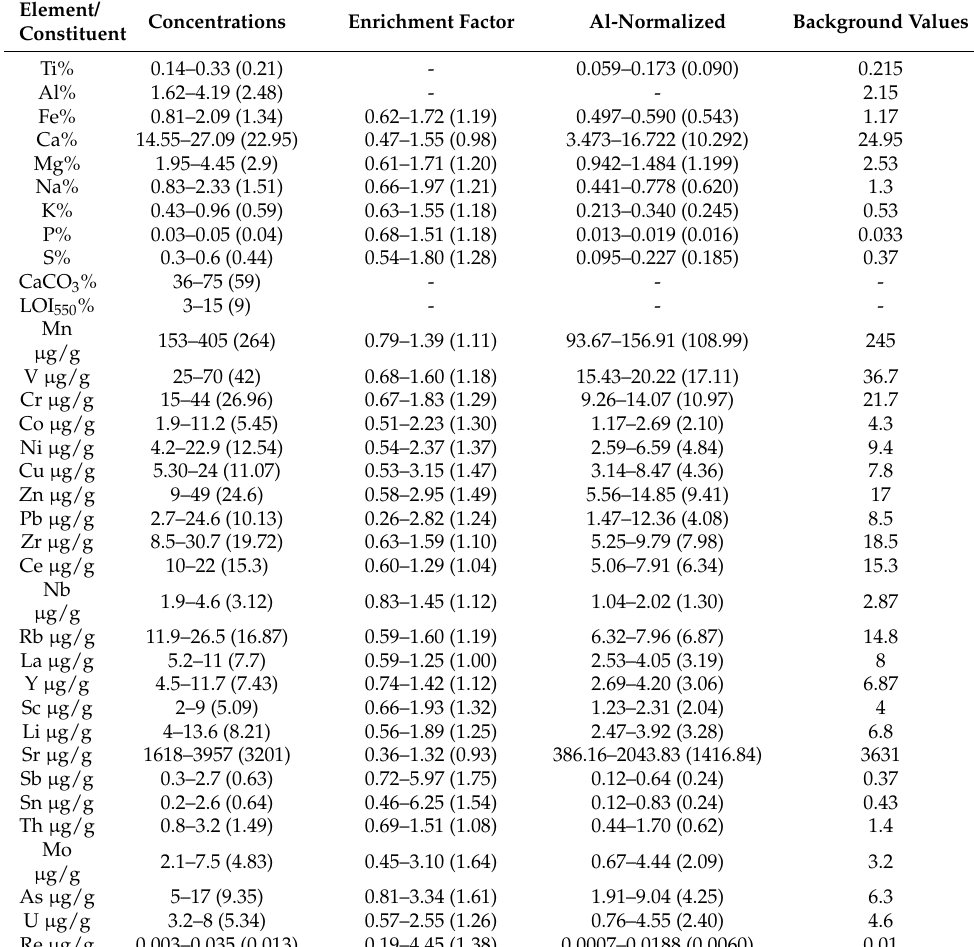
Table 1. Results of chemical analysis of the shallow subsurface coastal sediments of the creek that was connecting the two Al-Shuaiba Lagoons. Ranges and average (in brackets) of concentrations, enrichment factor ( EF ), Al-normalized elements, and the calculated background